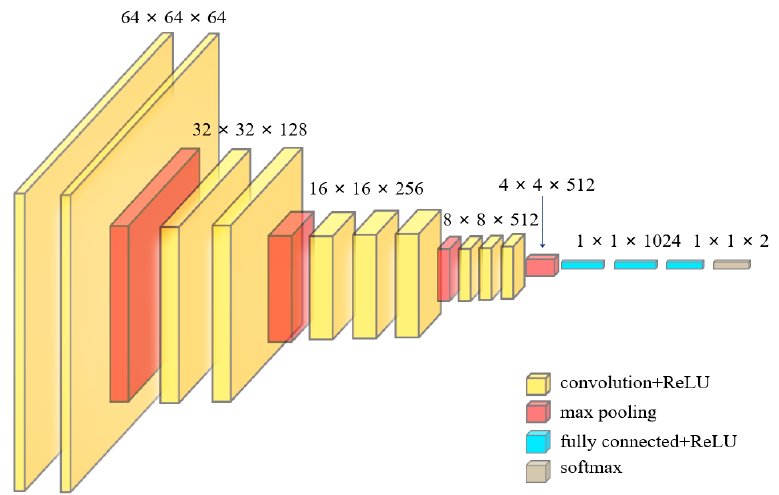
Figure 4. The structure of Binary Classification Network.